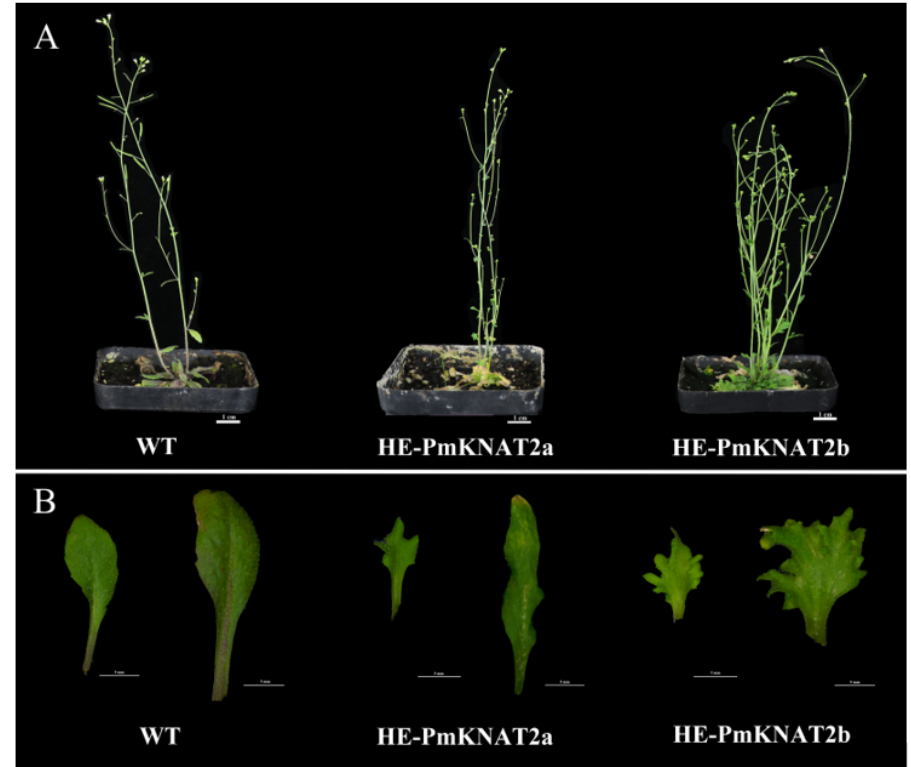
Figure 7. Phenotypic analysis of HE-PmKNAT2a and HE-PmKNAT2b. ( A ) Comparison of T1-generation transgenic plants with the highest heterologous expression and wild-type Arabidopsis . ( B ) Comparison of basal leaves of transgenic plants (left) and leaves on the main stem near the base (right) with WT plants. WT represents wild-type Arabidopsis , and HE-PmKNAT2a and HE-PmKNAT2b represent transgenic plants heterologously expressing the PmKNAT2a and PmKNAT2b genes in Arabidopsis , respectively.